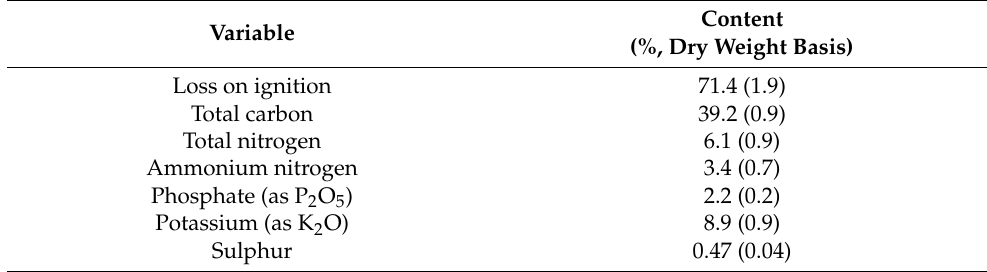
Table 1. Average composition of the digestate applied in the field trial (liquid phase) 2010–2017 ( n = 13, standard deviation in parentheses, laboratory analysis by Agrolab Labor